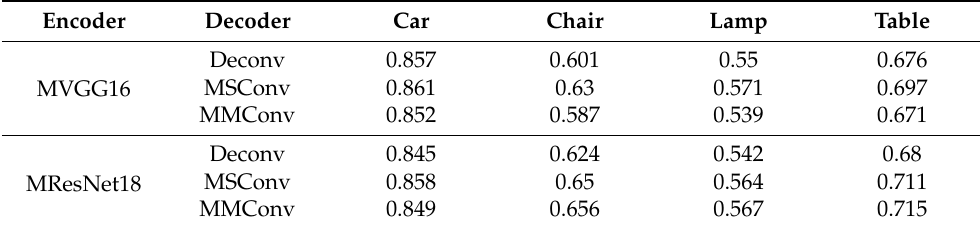
Table 2. IOU values of VoxGen under different encoder-decoder combinations.